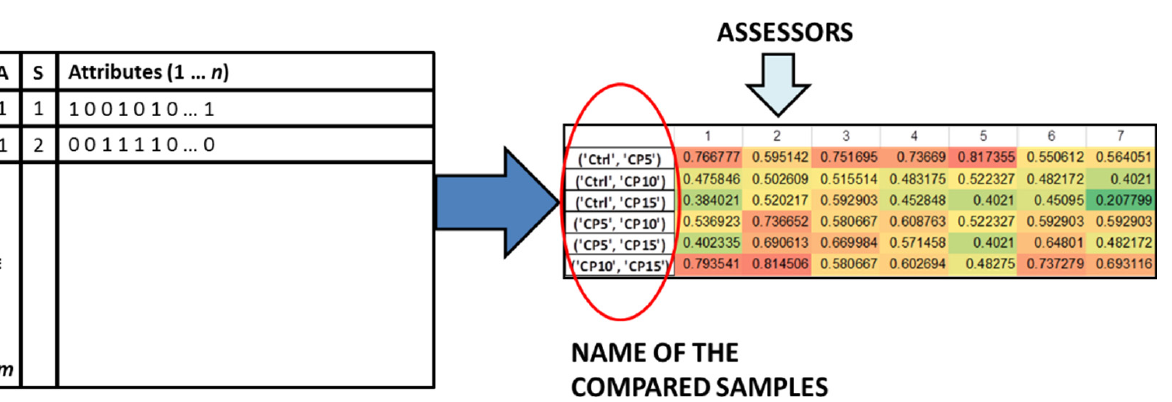
Table 3. Summary of the average similarity values and row minimum and maximum values for the heatmaps in each case study. Consensus Limit Selected Asses- sors *